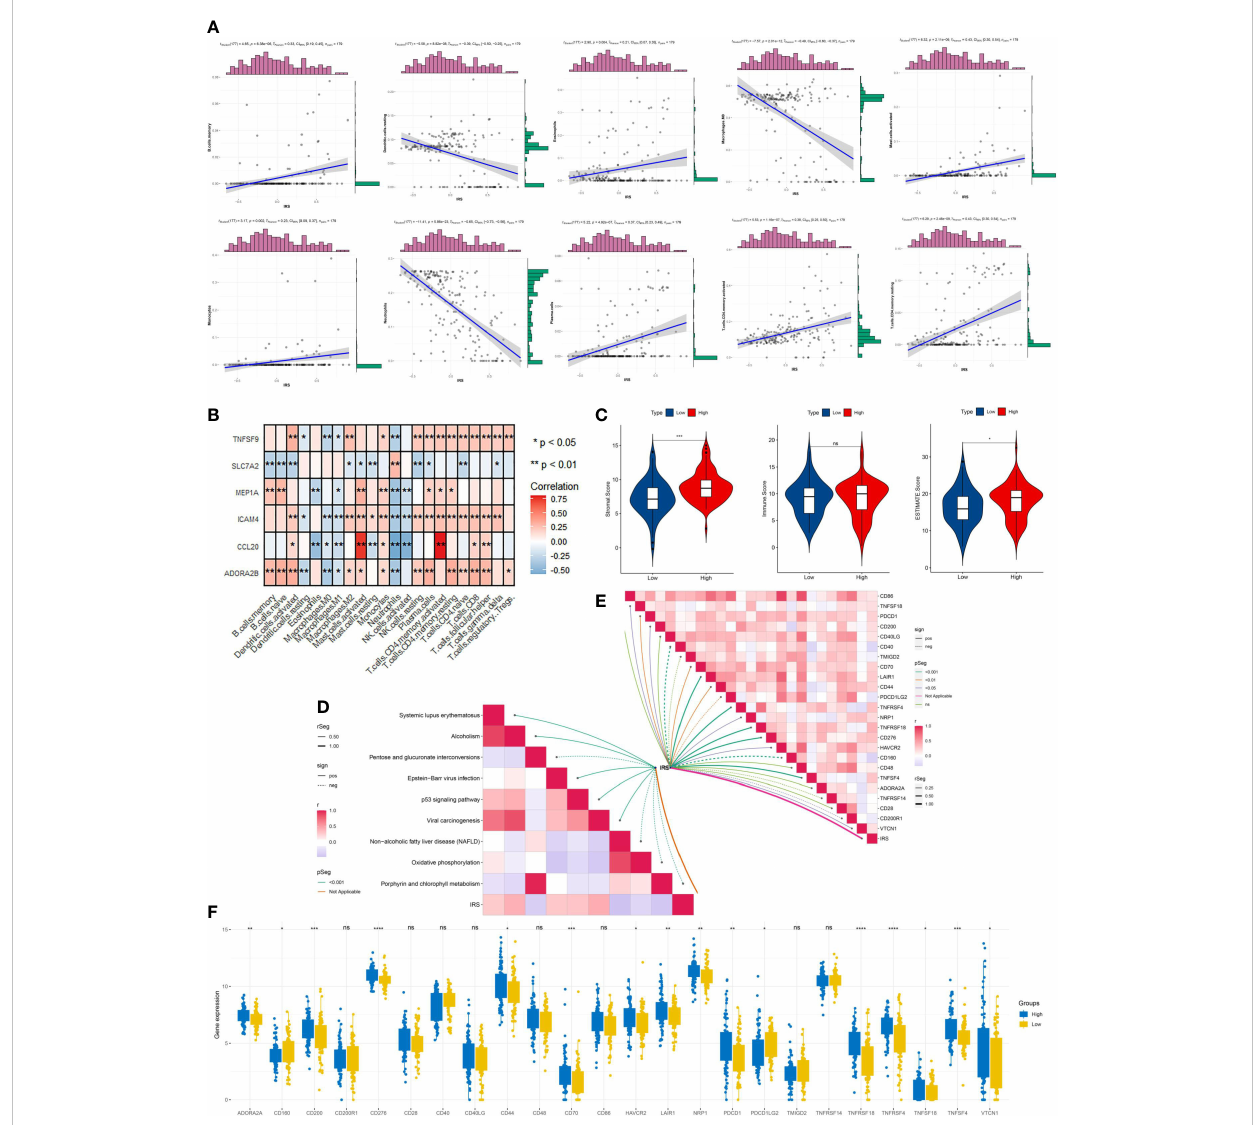
FIGURE 7 Immune signatures of different risk groups. (A) Correlations between IRG and immune cell types. (B) The correlations of immune cell in fi ltration and the hub six genes in the risk model. (C) Comparison of immune-related scores between low-risk and high-risk groups. (D) the association between IRG and the enrichment scores of immunotherapy response-related gene signatures or (E) IRG and the expression of many immune checkpoints. (F) The differentially expressed immune checkpoint-related genes between the high- and low risk groups. *p < 0.05, **p < 0.01, ***p < 0.001, ****p < 0.0001, ns, not signi fi